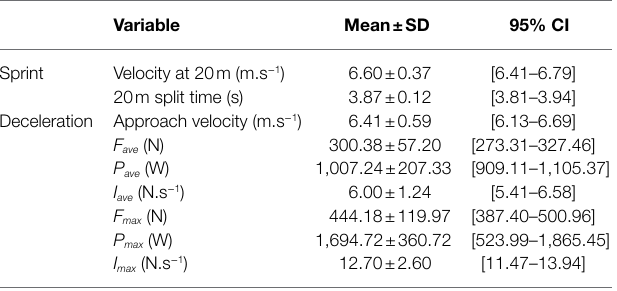
F ave , average braking force; P ave , average braking power; I ave , average braking impulse; F max , maximum braking force; P max , maximum braking power; I max , maximum braking impulse. All data are presented as mean ± standard deviation with 95% confidence